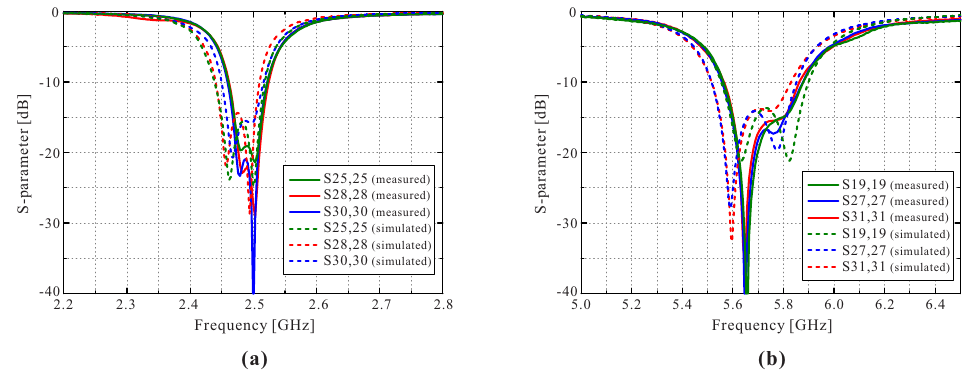
Figure 6. Reflection coefficients of the radiating elements in the proposed aperture-shared dual-band thinned array: ( a ) 2.4 GHz band; ( b ) 5.8 GHz band.